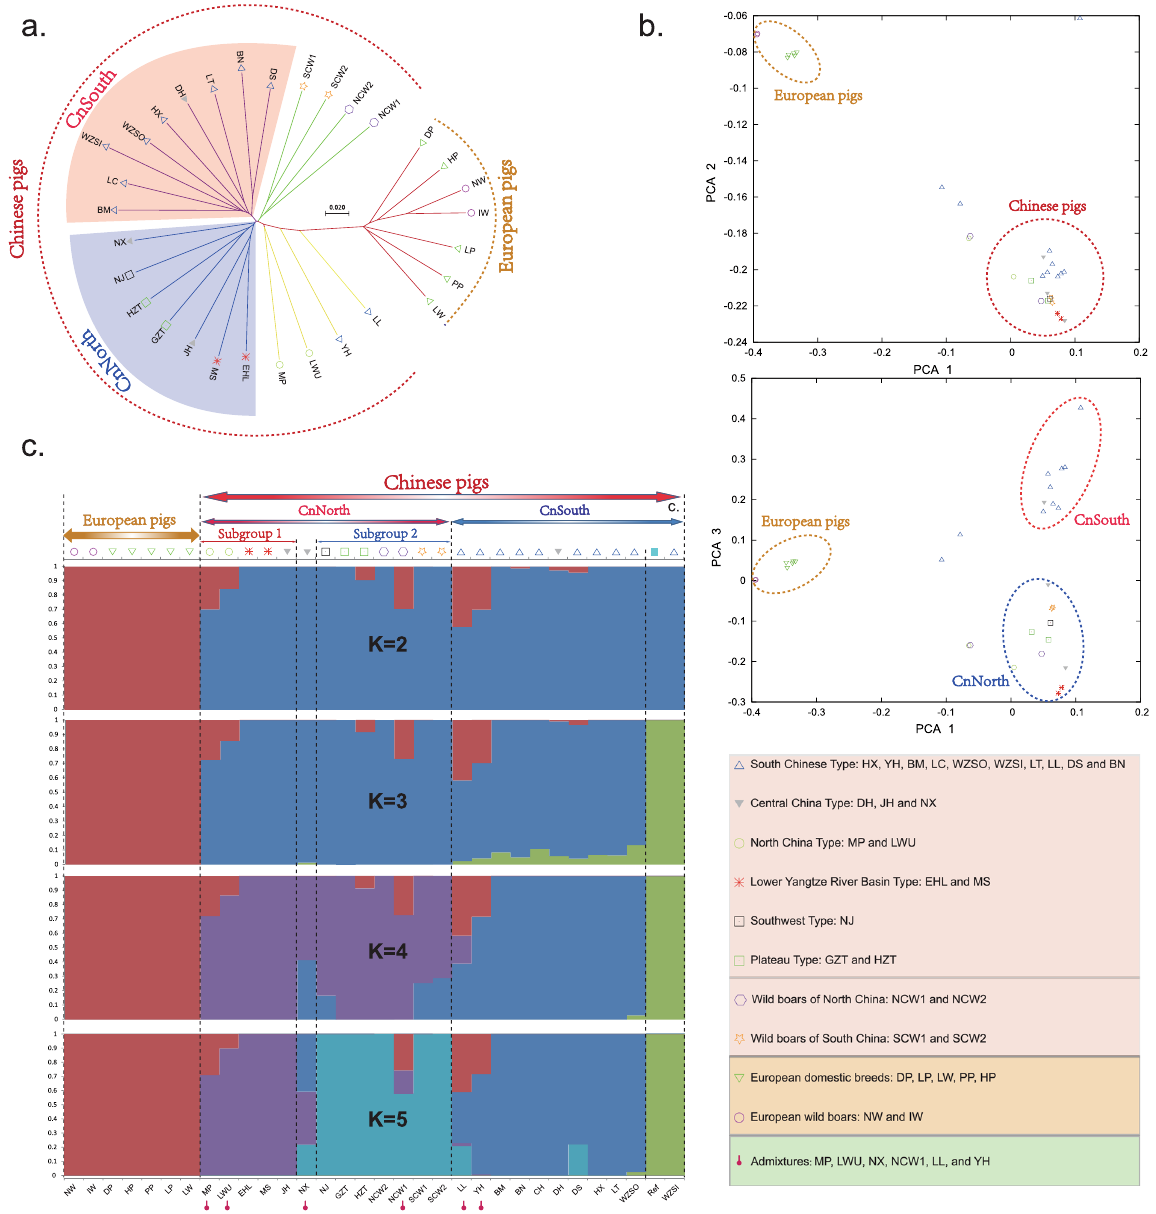
Figure 1. Population structure of wild and domestic pigs from different geographical regions. (a ) Neighbor- joining tree of all pigs based on the 9.2 million population SNPs. The scale bar denotes p distance between individuals. (b) PCA1-2 and PCA1-3 plots of all individuals. (c ) Genetic structure analysis of samples using FRAPPE, with changing ancestral populations from K = 2 to K =